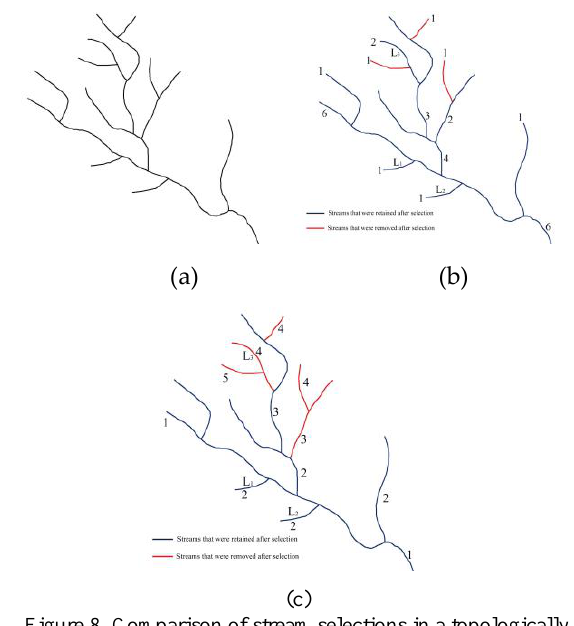
Figure 8. Comparison of stream selections in a topologically deep substream: (a) original map, (b) selections based on Horton’s coding system and (c) selections based on our coding